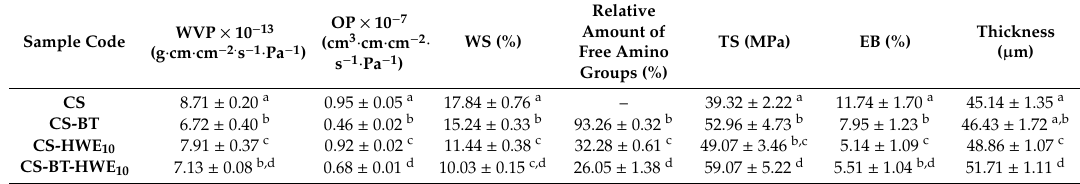
Table 2. Barrier properties, water solubility properties and mechanical properties of composite films.